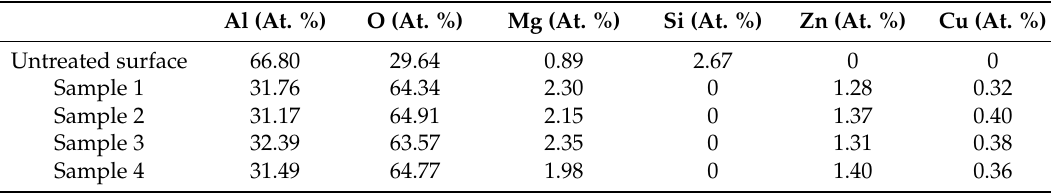
Table 2. Element contents of the microstructure surface calculated from XPS survey spectra. Al (At. %) O (At. %) Mg (At. %) Si (At. %) Zn (At. %) Cu (At. %) Untreated surface 66.80 29.64 0.89 2.67 0 0 Sample 1 31.76